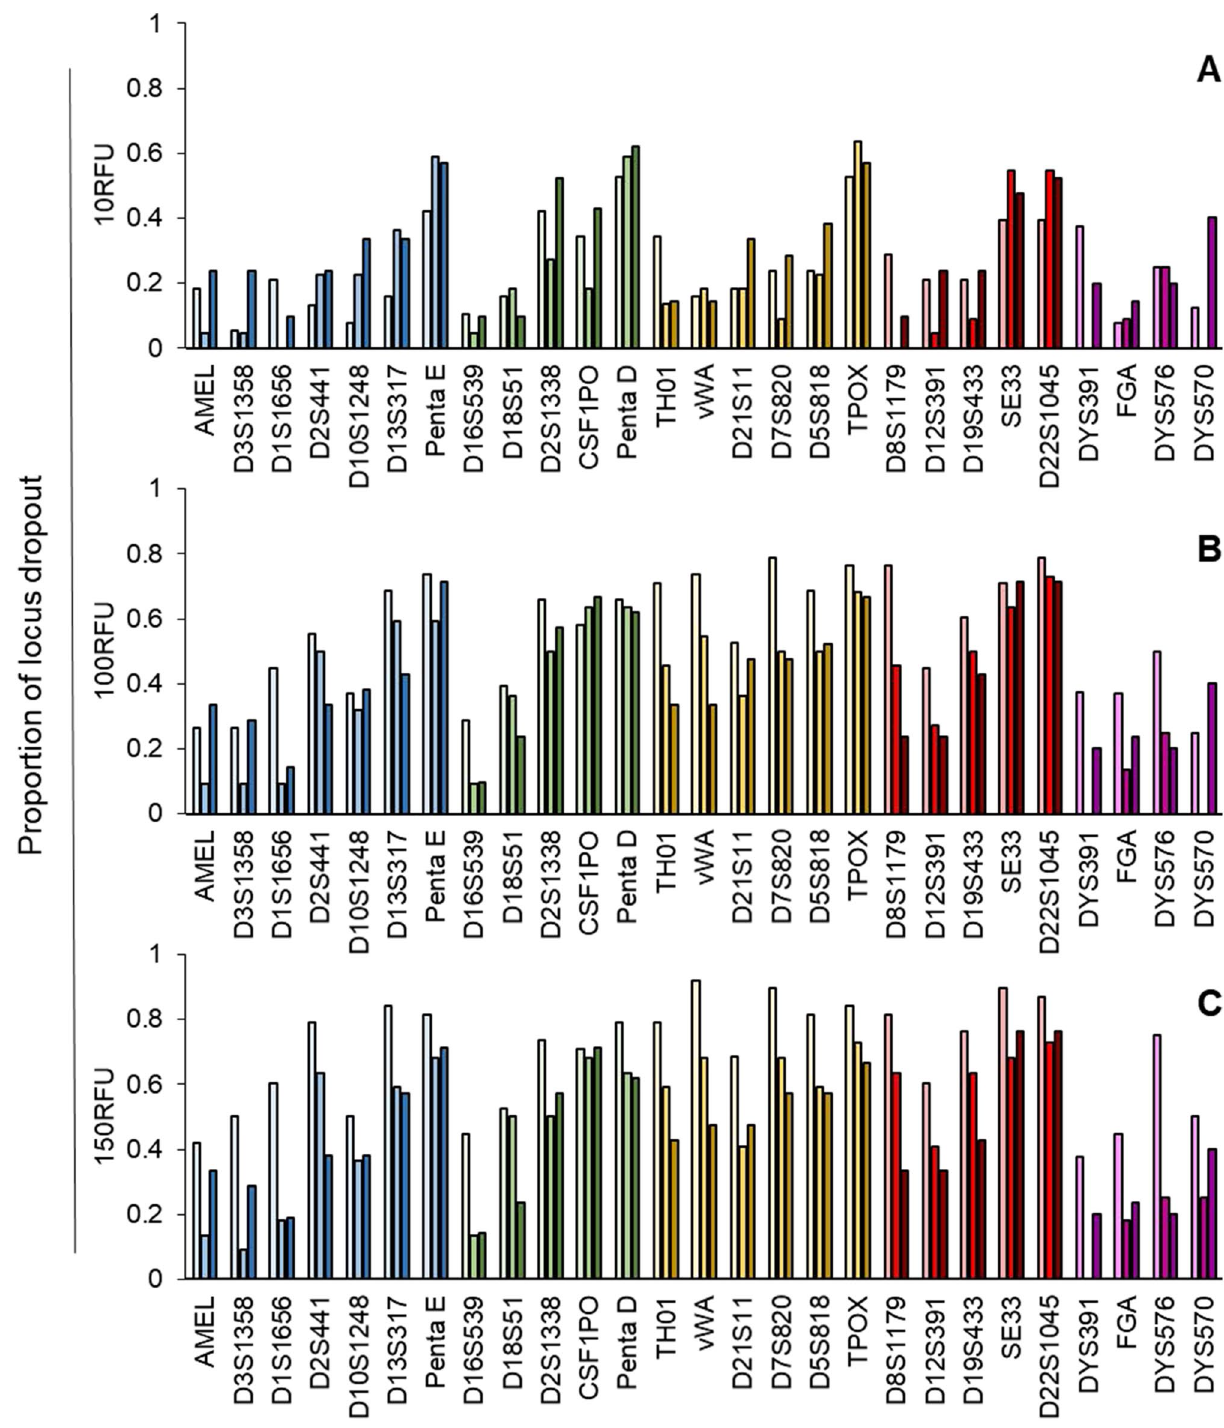
Figure 4. Average proportions of locus dropout by locus for single cells at 29, 30 and 31 cycles using the PowerPlex Fusion 6c kit analyzed at ( a ) 10 RFU, ( b ) 100RFU and ( c ) 150RFU. Cycle numbers within each locus from left to right are 29, 30, and 31, respectively and the colors (blue, green, yellow, red and purple) represent the dye